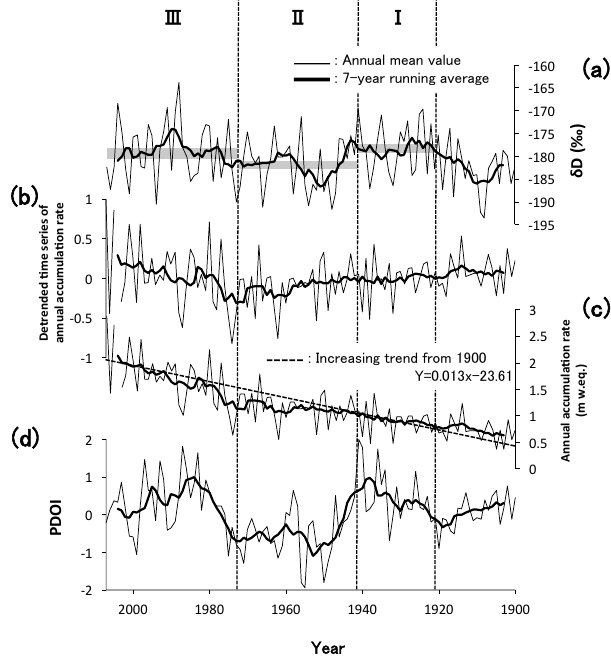
Figure 6. (a) Temporal variation in stable hydrogen isotopes ( δ D). The thick gray lines indicate average values of δ D in periods I (1923–1942), II (1943–1975), and III (1976–2007). (b) Detrended annual accumulation rates, which exclude the increasing trend from the annual accumulation rates. (c) Annual accumulation rates of the Aurora Peak ice core. Dotted lines show the increasing trend from 1900. (d) The Pacific Decadal Oscillation index (PDO). An- nual mean value given by the gray line; 7-year running averages given by the thick black